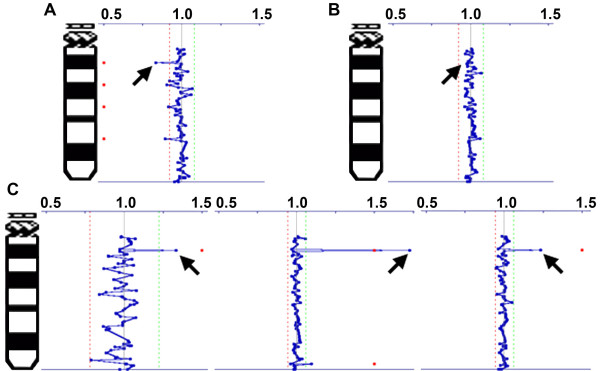
Microarray comparative genomic hybridization results for 5 chronic myeloid leukemia patients for chromosome 14. Arrow indicates CNV14q12. A) Arrow denotes 1 sample with a CNV14q12 deletion. B) Arrow denotes 1 sample with no change in the copy number of CNV14q12. C) Arrows show 3 samples with a copy number increase in the CNV14q12 region.